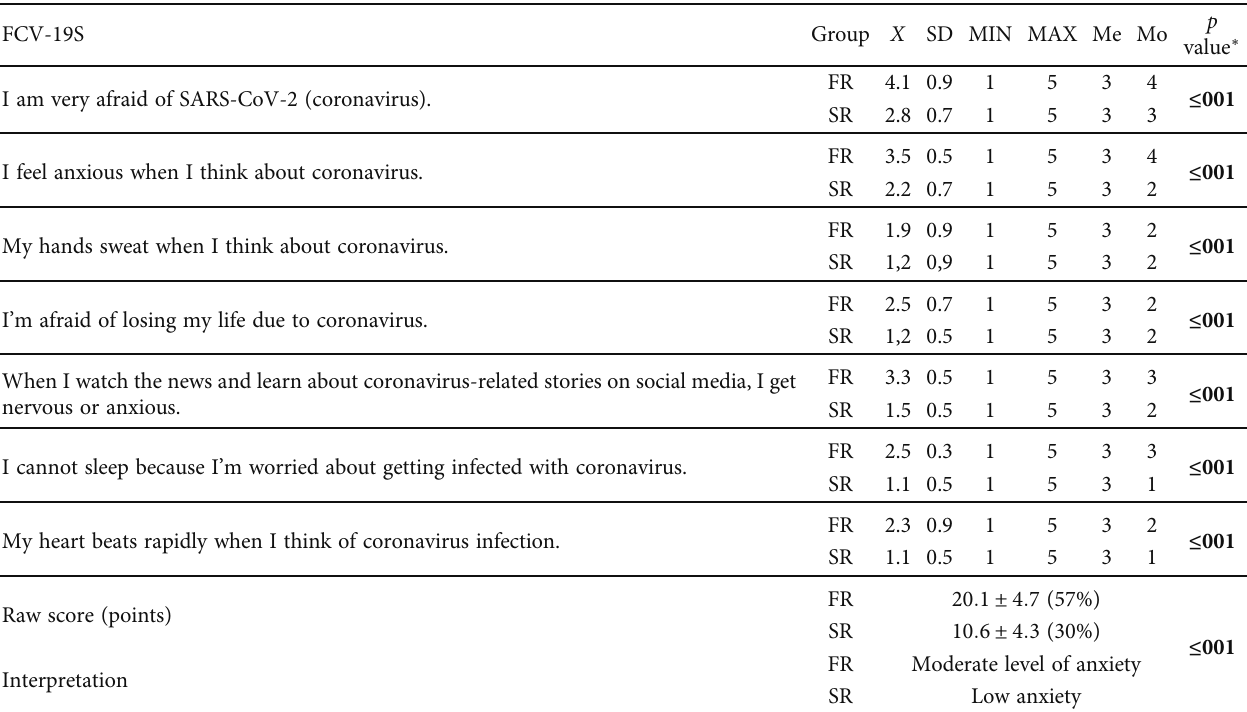
Table 3: FCV-19S results ( N = 300 ).